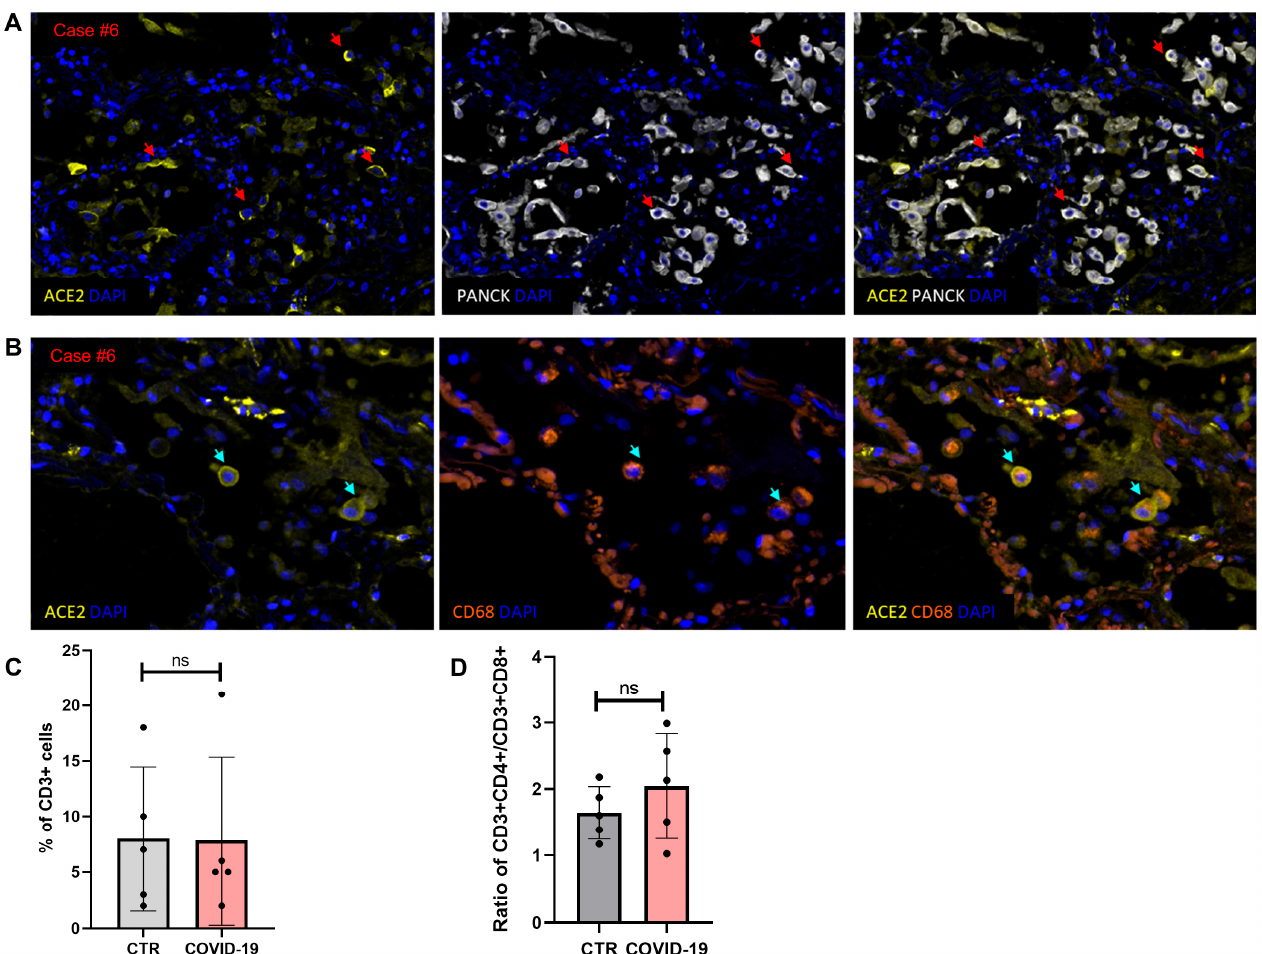
Figure 2. ( A , B ) Multiplex imaging analysis depicting expression of ACE2, the major receptor for SARS-CoV-2, in different cellular compartments of lung tissues in a representative patient with COVID-19 (case #6). ( A ) Red arrows point to ACE2- expressing pneumocytes, defined by double-expression of ACE2 (yellow) and PANCK (white). ( B ) Cyan arrows highlight ACE2-expressing macrophages, defined by double-expression of ACE2 (yellow) and CD68 (red). All images were acquired on the Vectra Polaris microscope using a 20x objective magnification, and zoomed in areas are depicted for visualization of macrophages. ( C ) The was no difference in the relative frequencies (% of total imaged cells) of CD3+ T cells in lung control tissues (non-COVID-19 DAD, n = 5) and COVID-19 lung tissues ( n = 5), expressed as mean values with SD at the scatter dot plots (Mann–Whitney U test, p = 0.87). ( D ) There was no statistically significant difference of the CD4+ to CD8+ T lymphocyte ratio between the two cohorts (Mann–Whitney U test, p = 0.55).